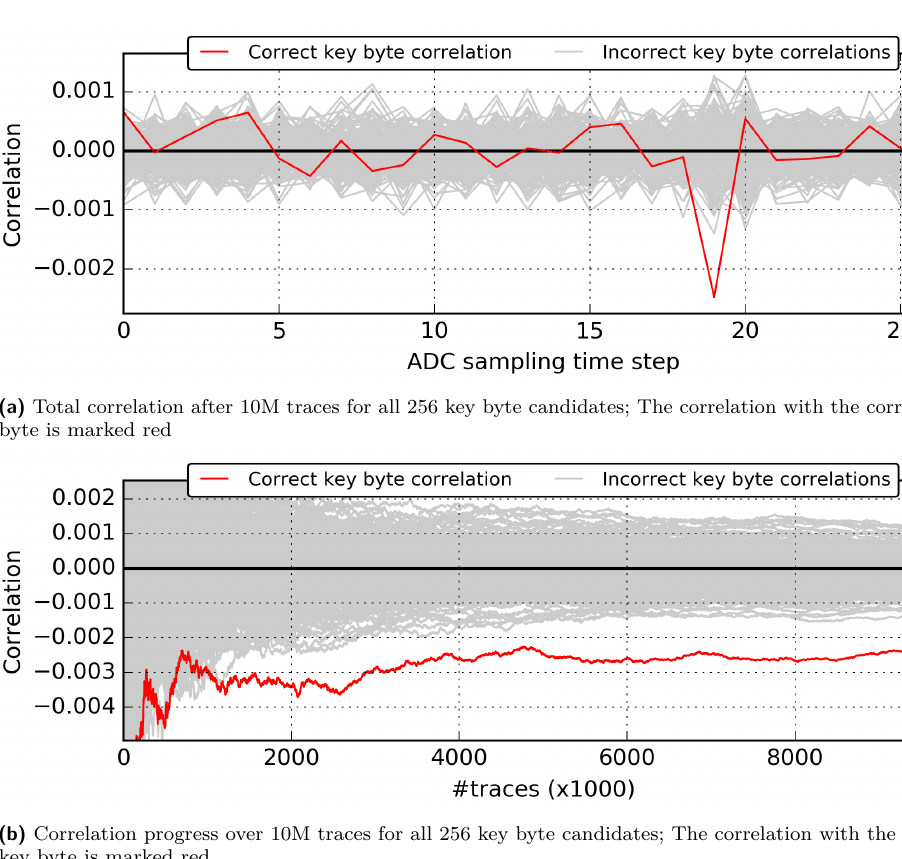
Figure 11: Results of a CPA attack on the 6th byte of the last secret round key of AES on the STM32F407VG Discovery #1 @168MHz with the ADC connected to GND and the program compiled with the -Os optimization option (like for leakage